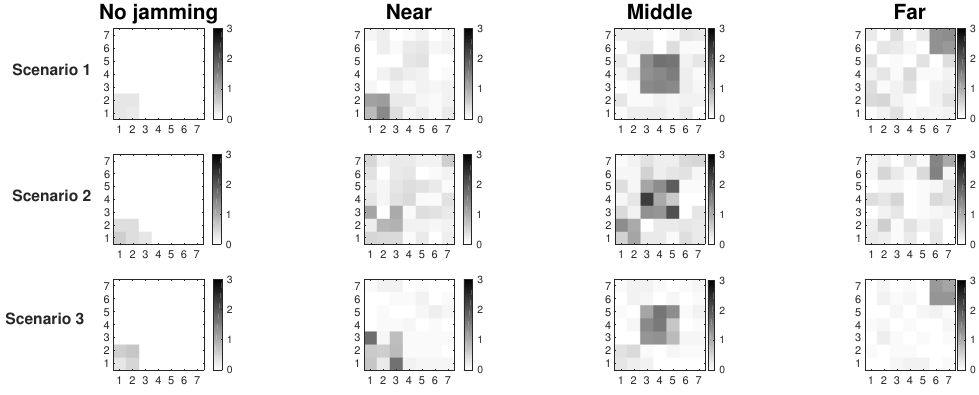
Figure 2. Three scenarios using the detection technique over MPH